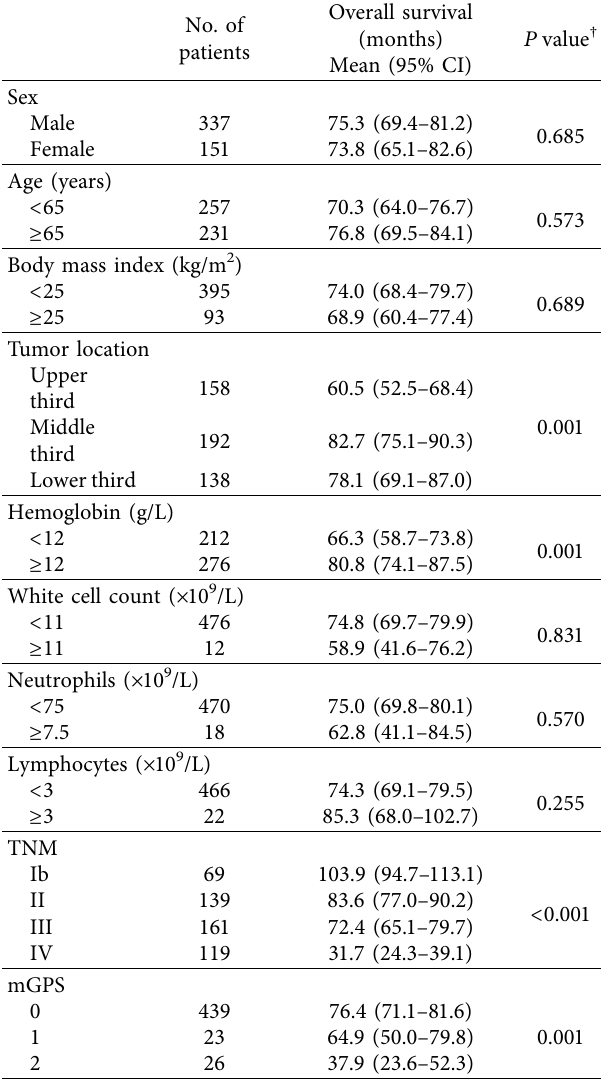
Table 1: Relationships between clinicolaboratory characteristics and the modified Glasgow prognostic score